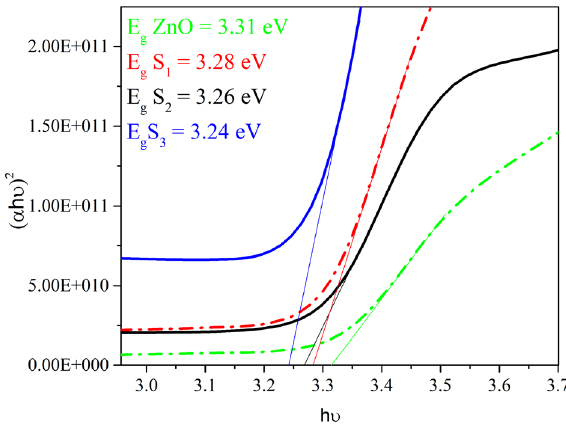
Figure 4. Optical bandgap energy of all samples.